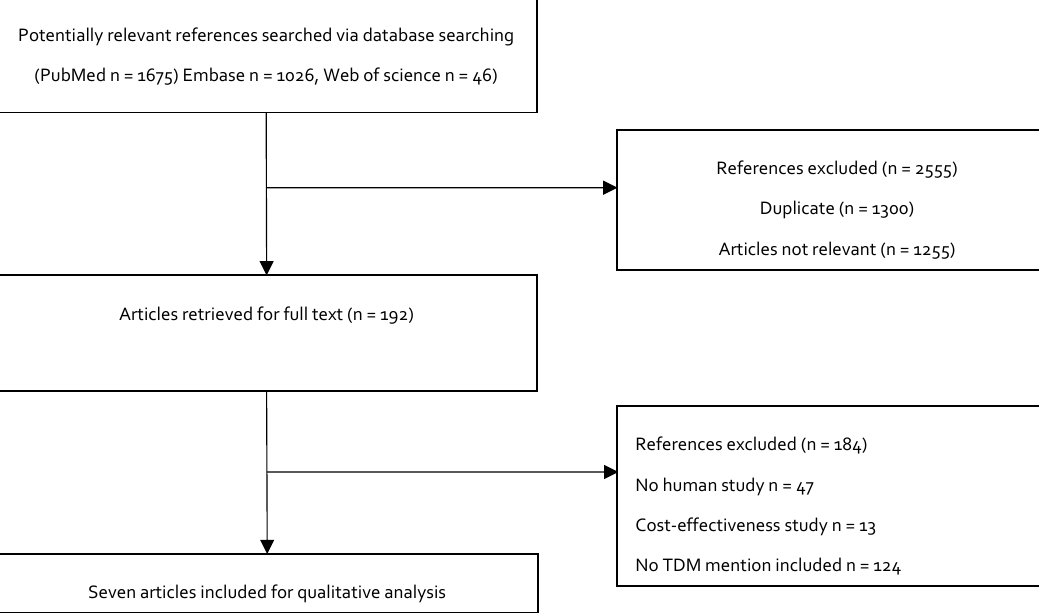
Figure 3. Flowchart depicting the selection process for the studies included in the paper.